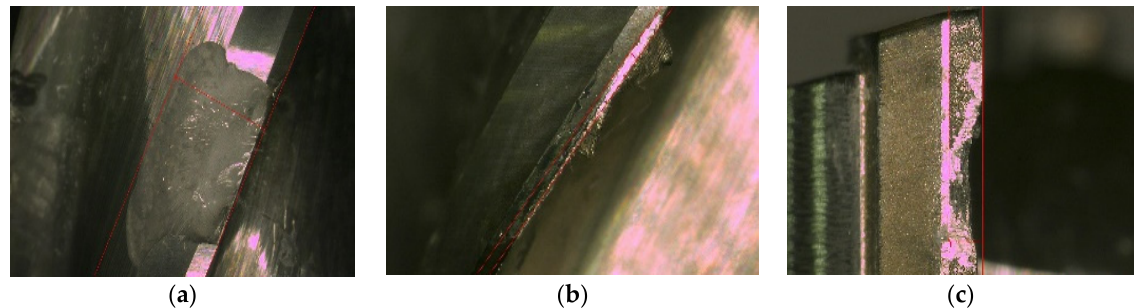
Figure 24. Tool wear for each cutter using the worst cutting conditions: ( a ) tool1, ae of 4.3 mm, v of 300 m/min and ft of 0.25 mm/tooth; ( b ) tool2, ae of 4.3 mm, v of 300 m/min and ft of 0.25 mm/tooth; ( c ) tool3, ae of 1 mm, v of 300 m/min and ft of 0.25 mm/tooth.